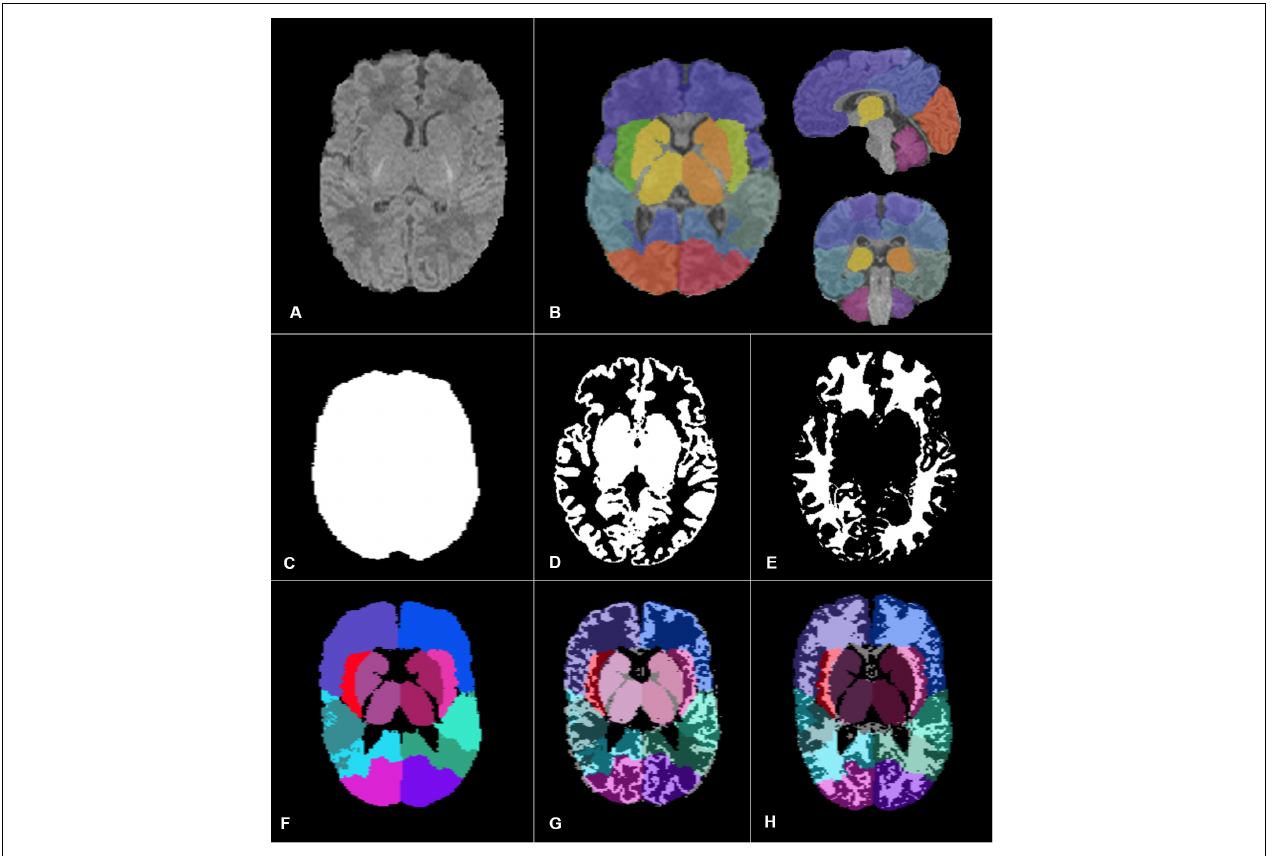
FIGURE 2 | Images and segmentation obtained through our pipeline adapted for preterm infants. We performed brain extraction first (A) , then we built, from ALBERTs data, a simplified segmentation of the brain into 14 larger regions (B) . To perform MRI quantitative parameters analysis, we calculated our different ROIs: the overall brain (C) , the overall GM (D) , and WM (E) , the eight anatomical regions (F) . Panels (G,H) correspond to the regional GM ROIs and the regional WM ROIs,